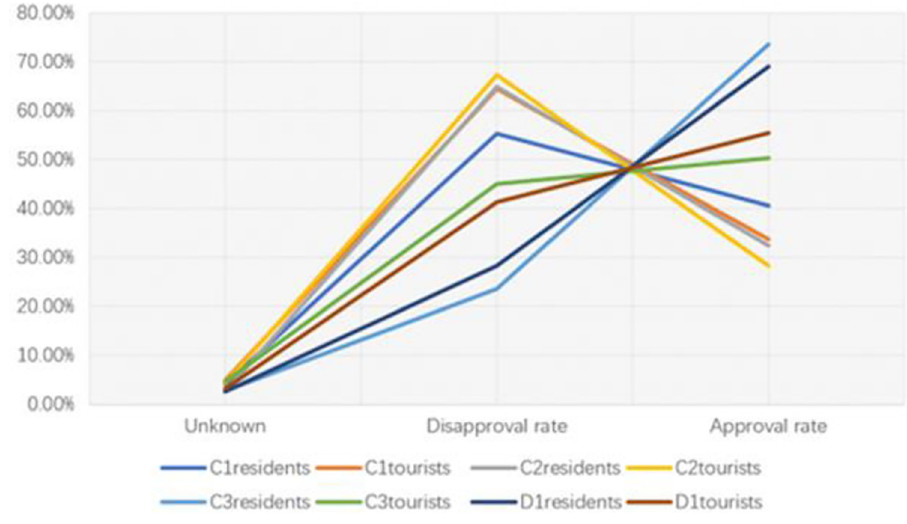
Fig 2. Comparison of C1, C2, C3, D1